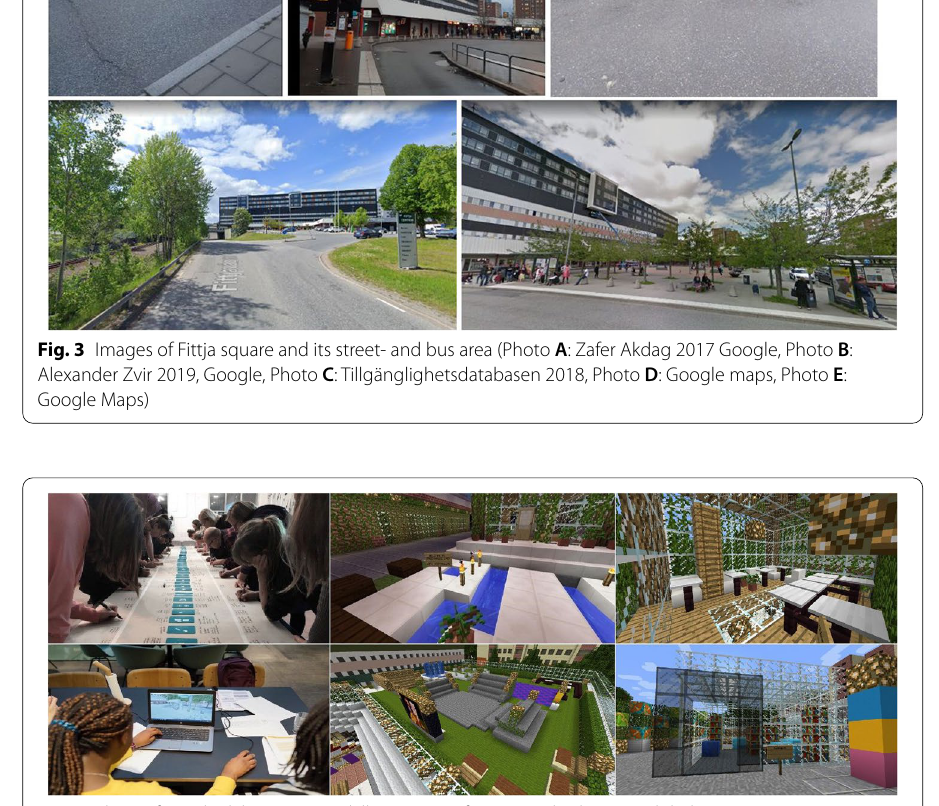
Fig. 4 Photos from the lab process and illustrations of suggested solutions (Global